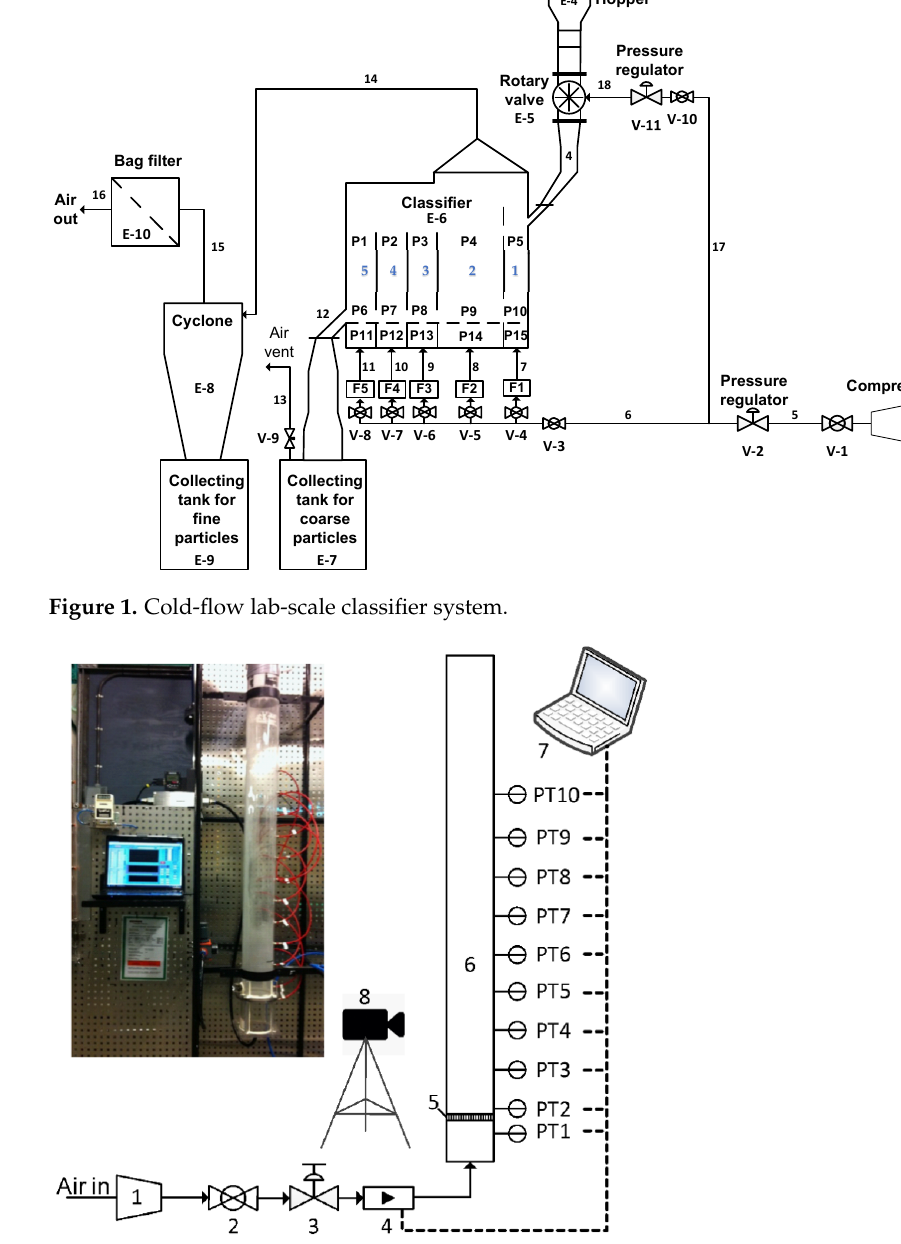
Figure 2. Fluidized bed experimental rig: 1—compressor, 2—ball valve, 3—pressure regulator, 4—mass flow controller, 5—air distribution plate, 6—fluidized bed column, 7—DAQ and LabVIEW, 8—video camera.